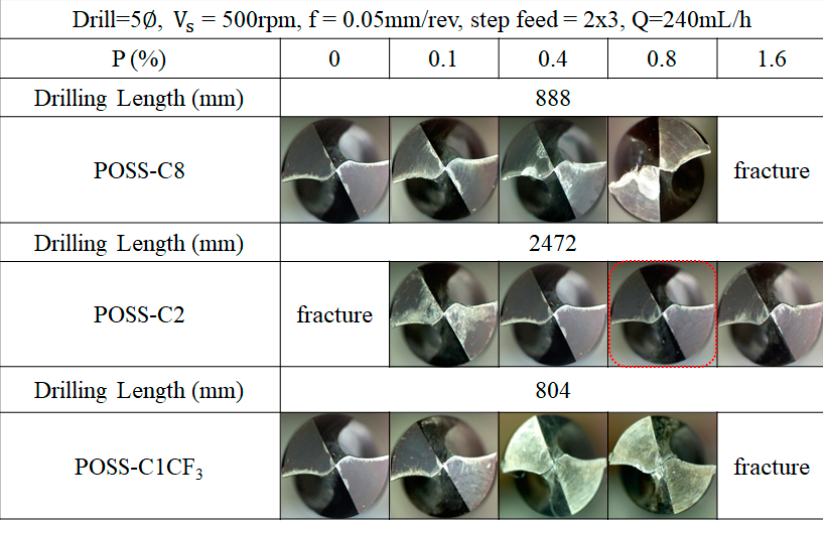
Figure 9. Comparison of tool wear according to P(%).